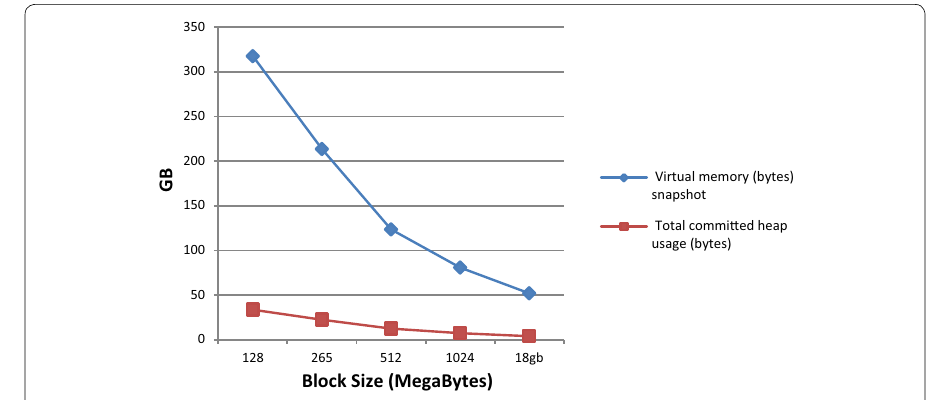
Fig. 30 Resources utilized in the case on 1 node